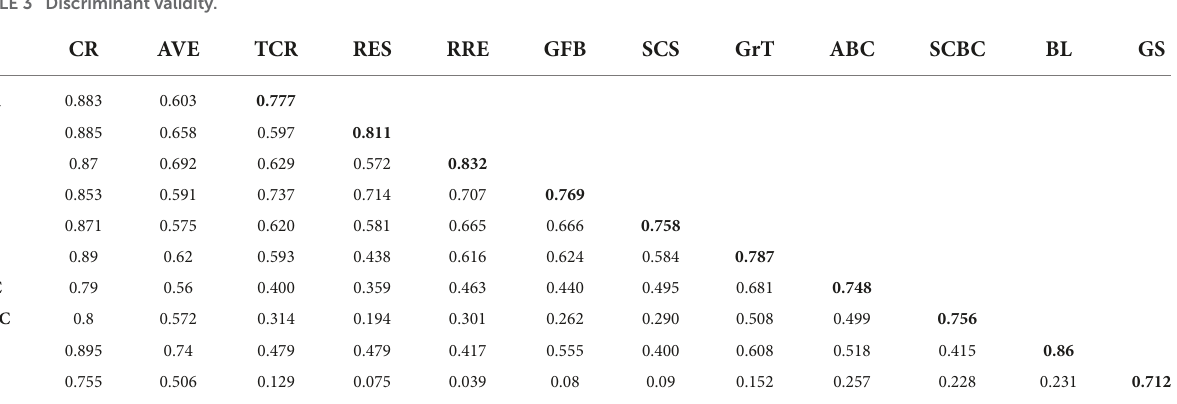
TABLE 3 Discriminant validity.